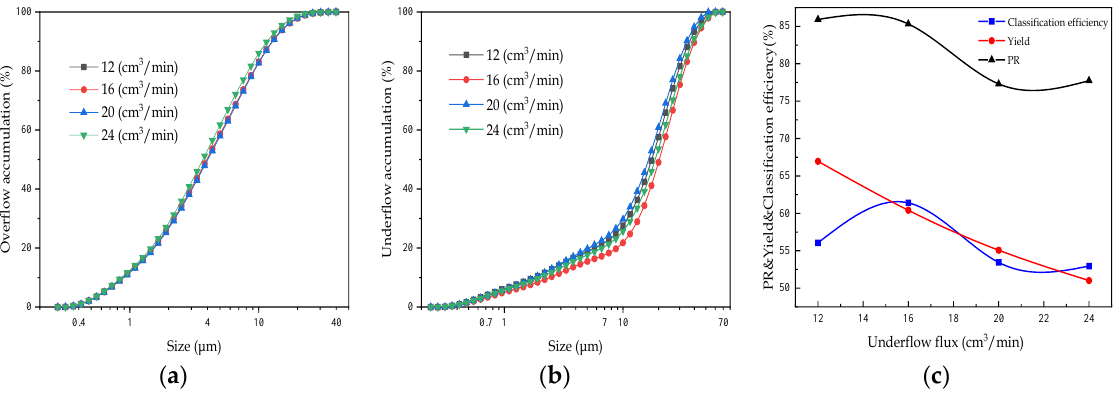
Figure 8. ( a ) Overflow particle size; ( b ) underflow particle size; ( c ) classification index. Experiment on the effect of underflow flux condition.